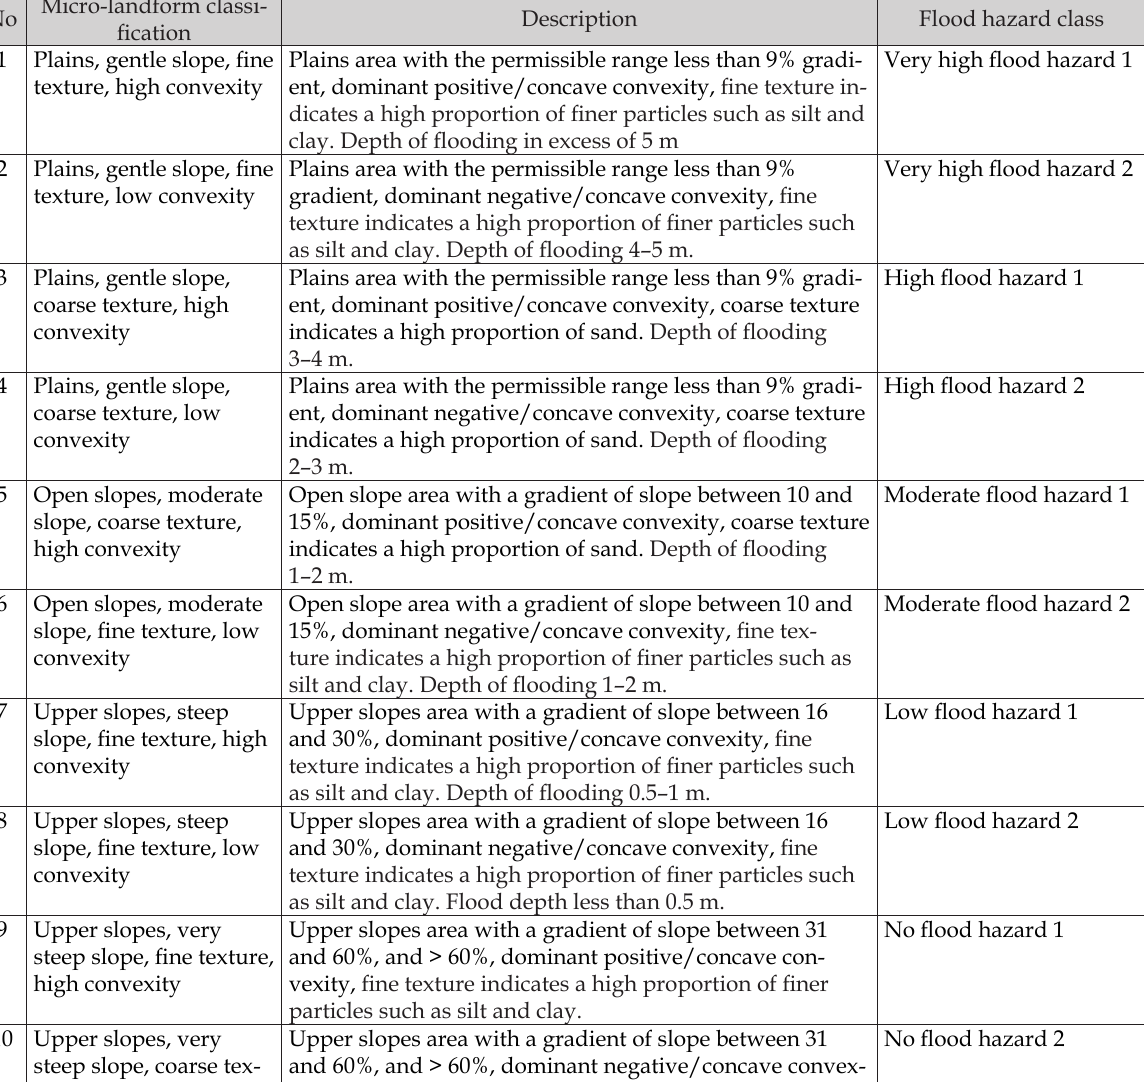
Table 4. Terrain surface classification (TSC) micro-landform characteristics related to flood conditions in the study